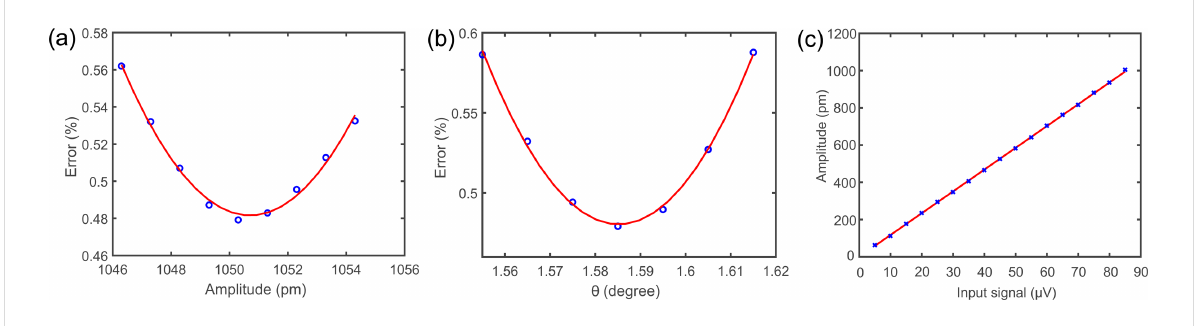
Figure 6: Error as a function of A and θ . (a) The blue circles show the calculated error for varying amplitudes. The other parameters θ , z 0 , and x offset were kept constant. The red curve shows a parabolic fit through the points to estimate the uncertainty of the fitted A and yielded a value of 0.002 pm. (b) The calculated error for varying θ shown by the blue circles. The other parameters A , z 0 , and x offset were kept constant. The red curve shows a parabolic fit through the points to estimate the uncertainty of the fitted θ and yielded a value of 0.001°. (c) Amplitude as a function of the drive signal.